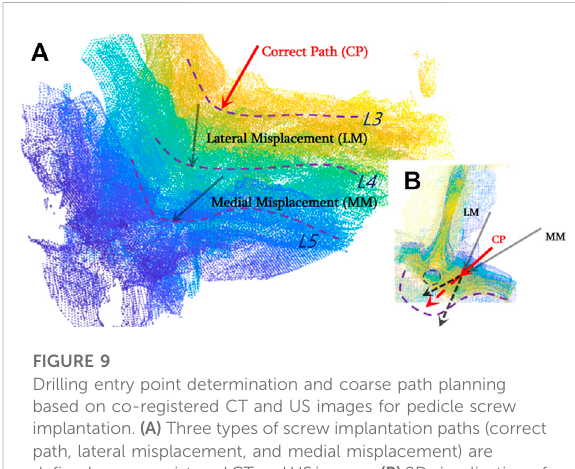
FIGURE 9 Drilling entry point determination and coarse path planning based on co-registered CT and US images for pedicle screw implantation. (A) Three types of screw implantation paths (correct path, lateral misplacement, and medial misplacement) are de fi nedonco-registeredCTandUSimages; (B) 2Dvisualizationof three typical screw implantation